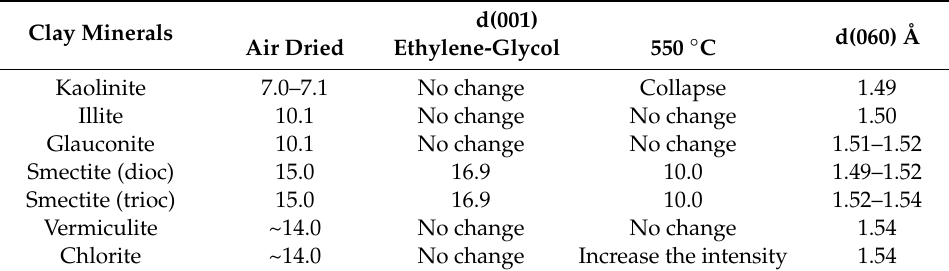
Table 2. Clay minerals and their 001 and 060 peaks